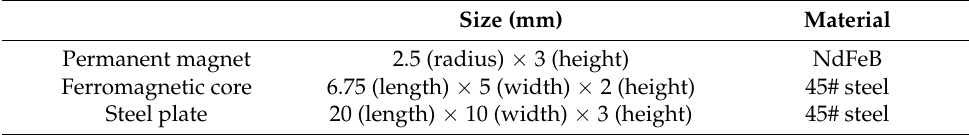
Table 1. Parameters of the model.